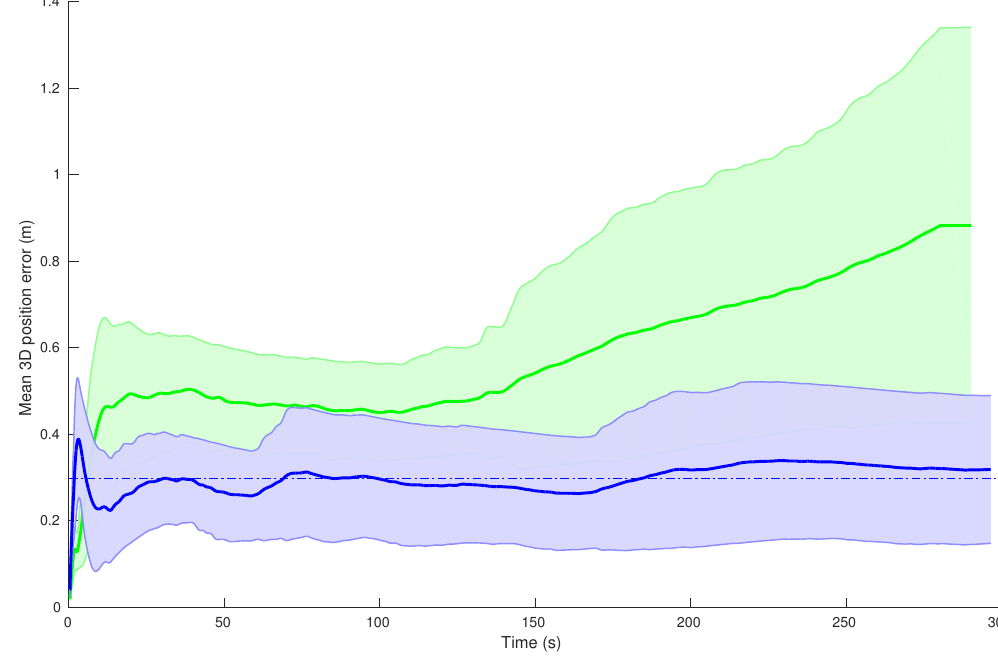
Figure 10. Mean position errors measured during two hover tests, one using the snapshot-based approach (blue) for the computation of sparse optic flow, and the other using traditional frame-to-frame optic flow measurements (green), conducted at the same location. Standard deviations of the mean position errors are depicted by the shaded areas. Reproduced with permission from